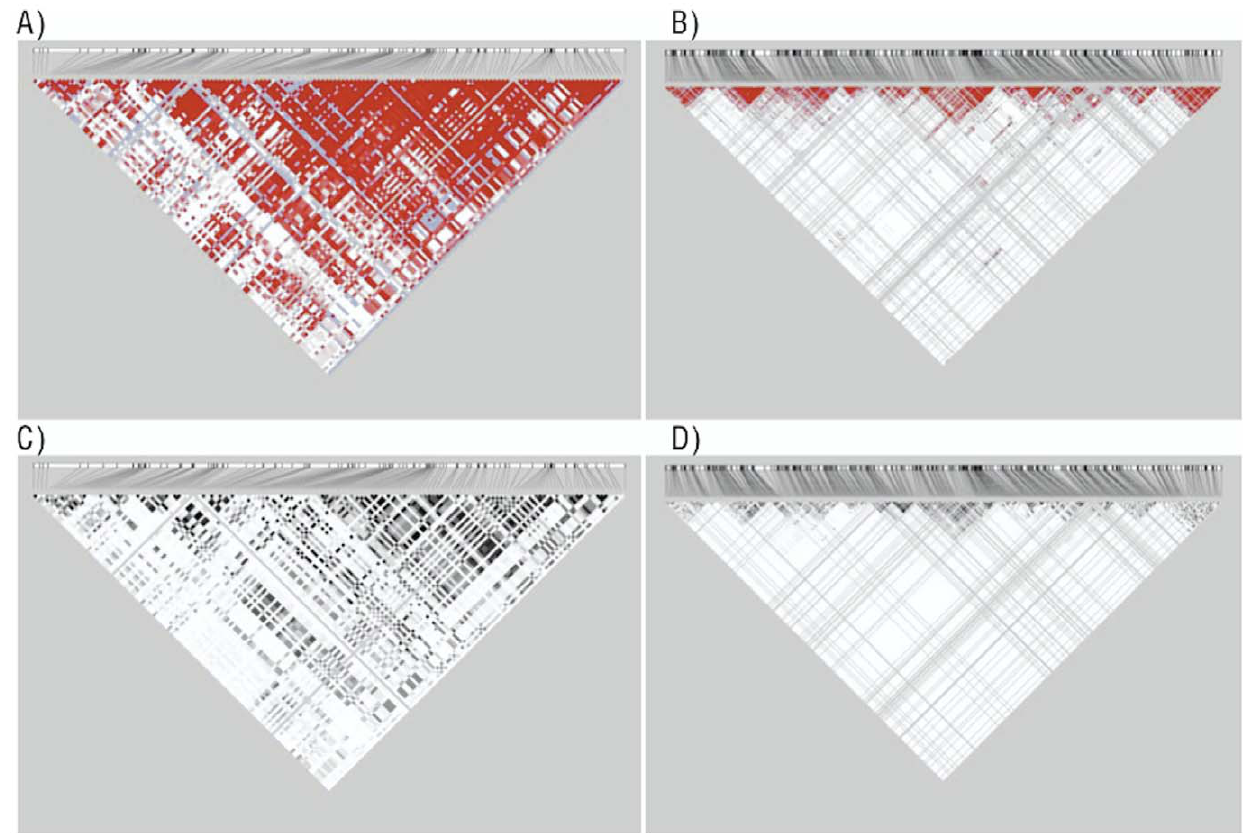
Figure 1. Gene Region LD plots. A) D’ Gene Region 1 (300 Kb), B) D’ Gene Region 2 (1000 Kb), C) r 2 Gene Region 1 (300 Kb), D) r 2 Gene Region 2 (1000 Kb).